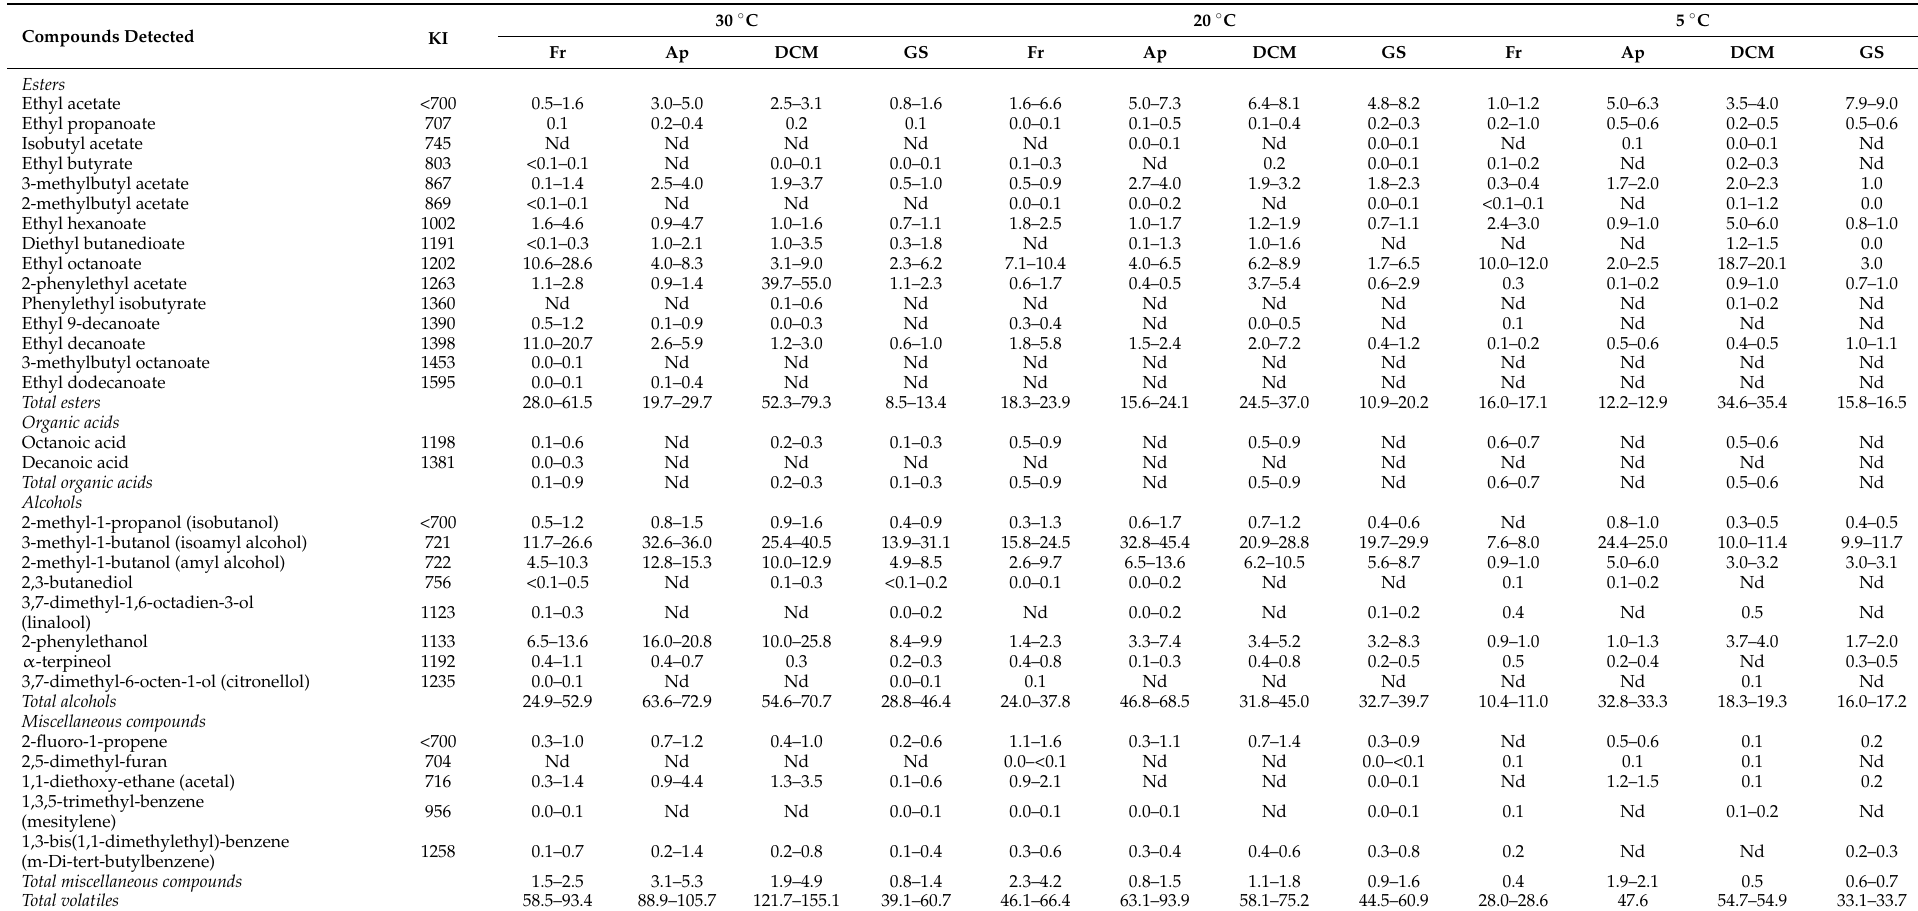
Table 5. Minor volatile compounds (mg/L) identified by HS-SPME GC/MS in low alcohol wines fermented at various temperatures (5–30 ◦ C) by